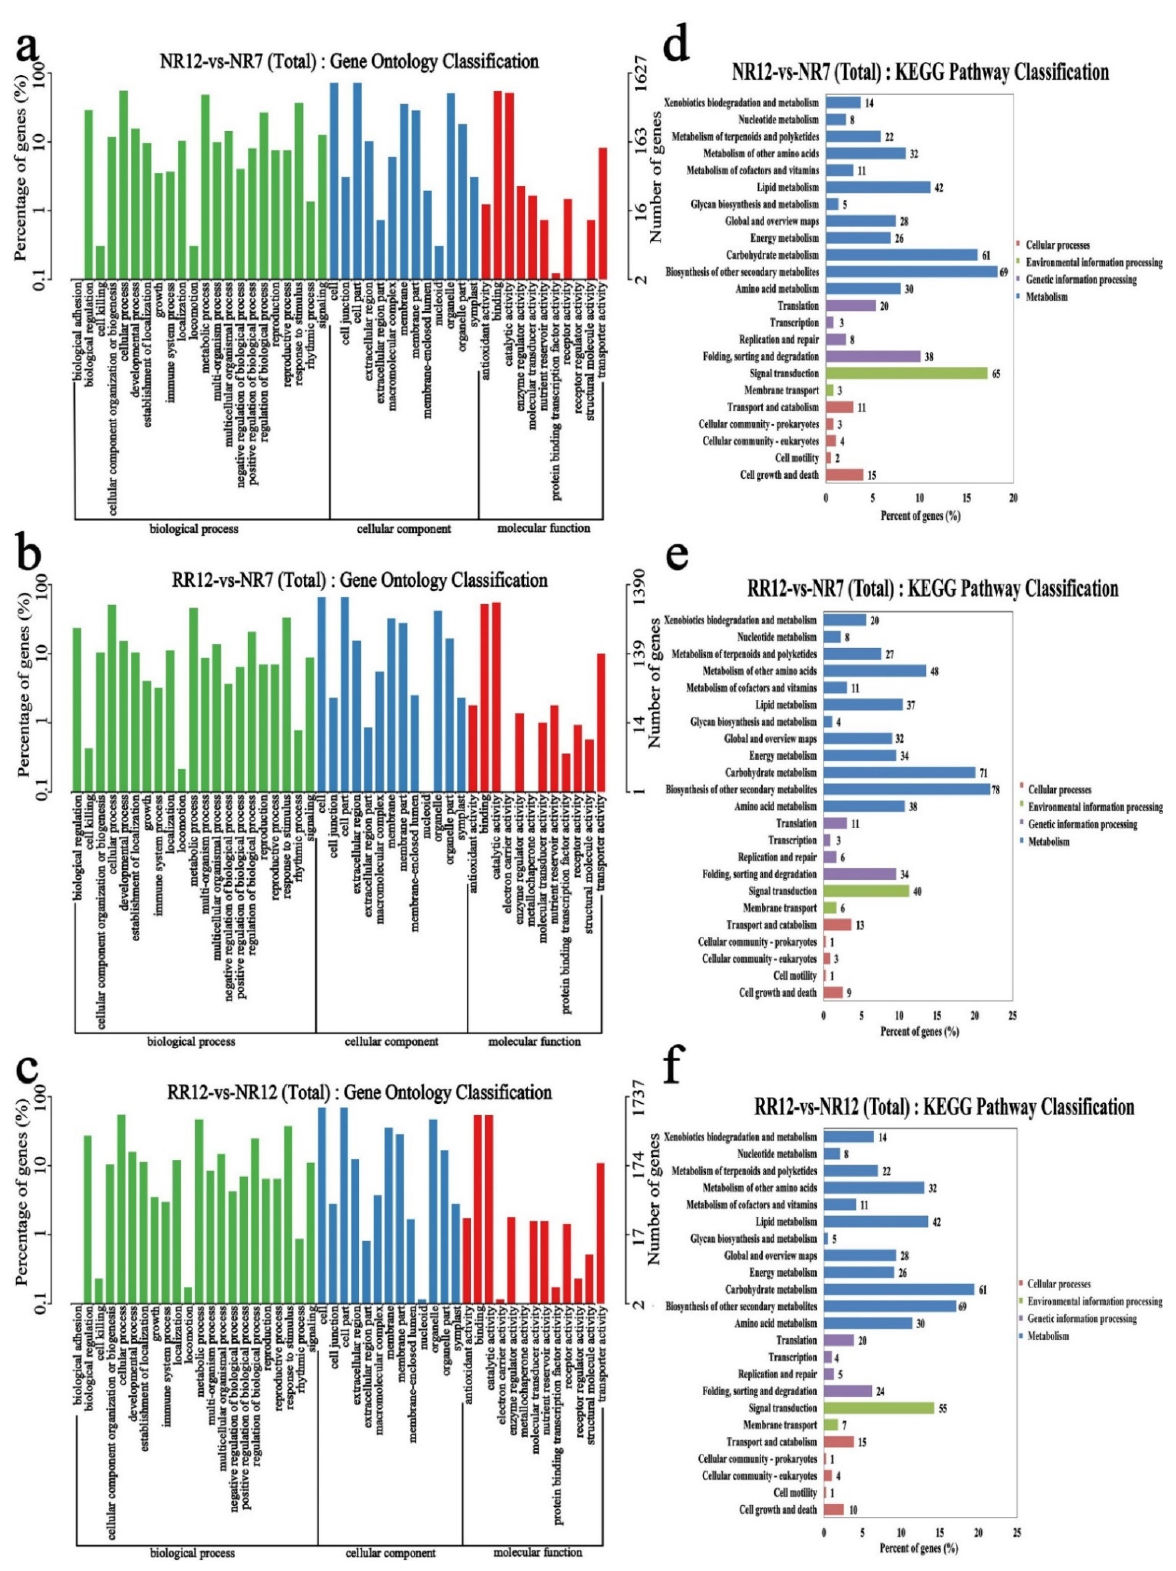
Figure 6. The functional analysis results of differentially expressed mRNAs. GO enrichment ( a – c ) and KEGG pathway ( d – f ) in NR12_vs_NR7, RR12_vs_NR7, RR12_vs_NR12.